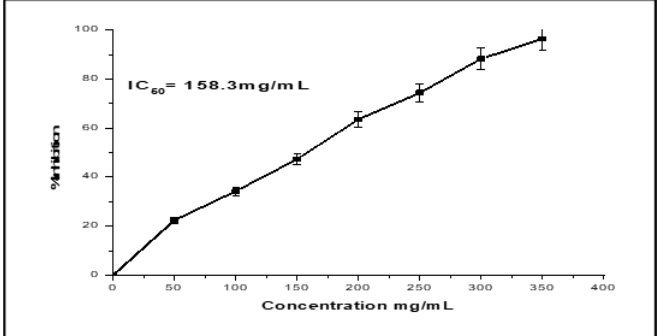
Figure 5. The dose-dependent cytotoxic effect of okra extract against HepG2 cells. All tests were performed in triplicate, and data are expressed as mean ± standard deviation.